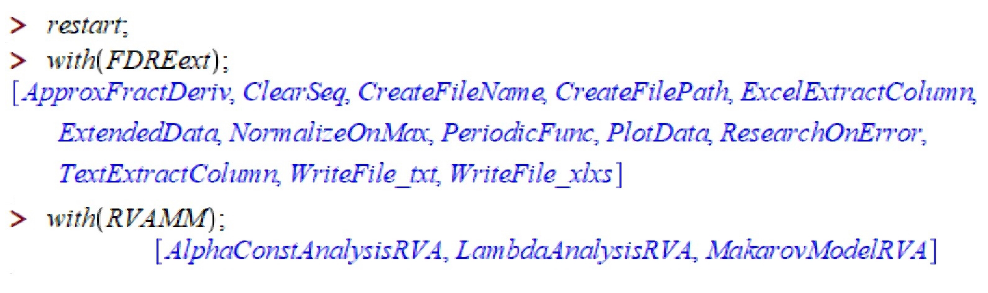
Figure 6. Library call